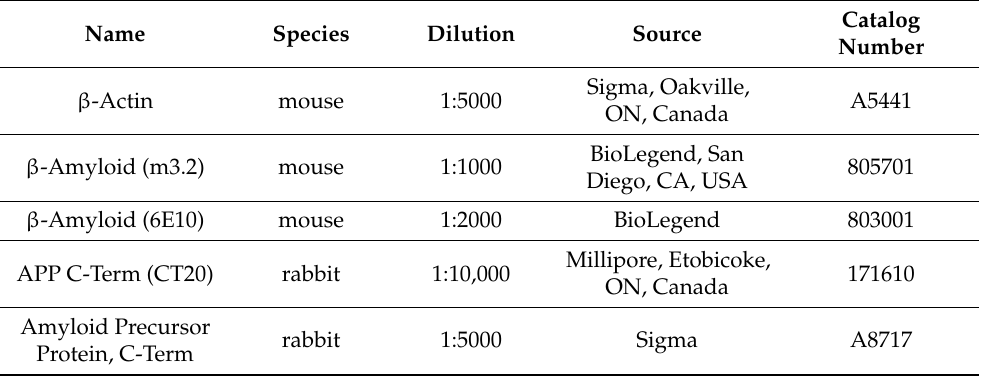
Table 1. Antibodies used for Western blot